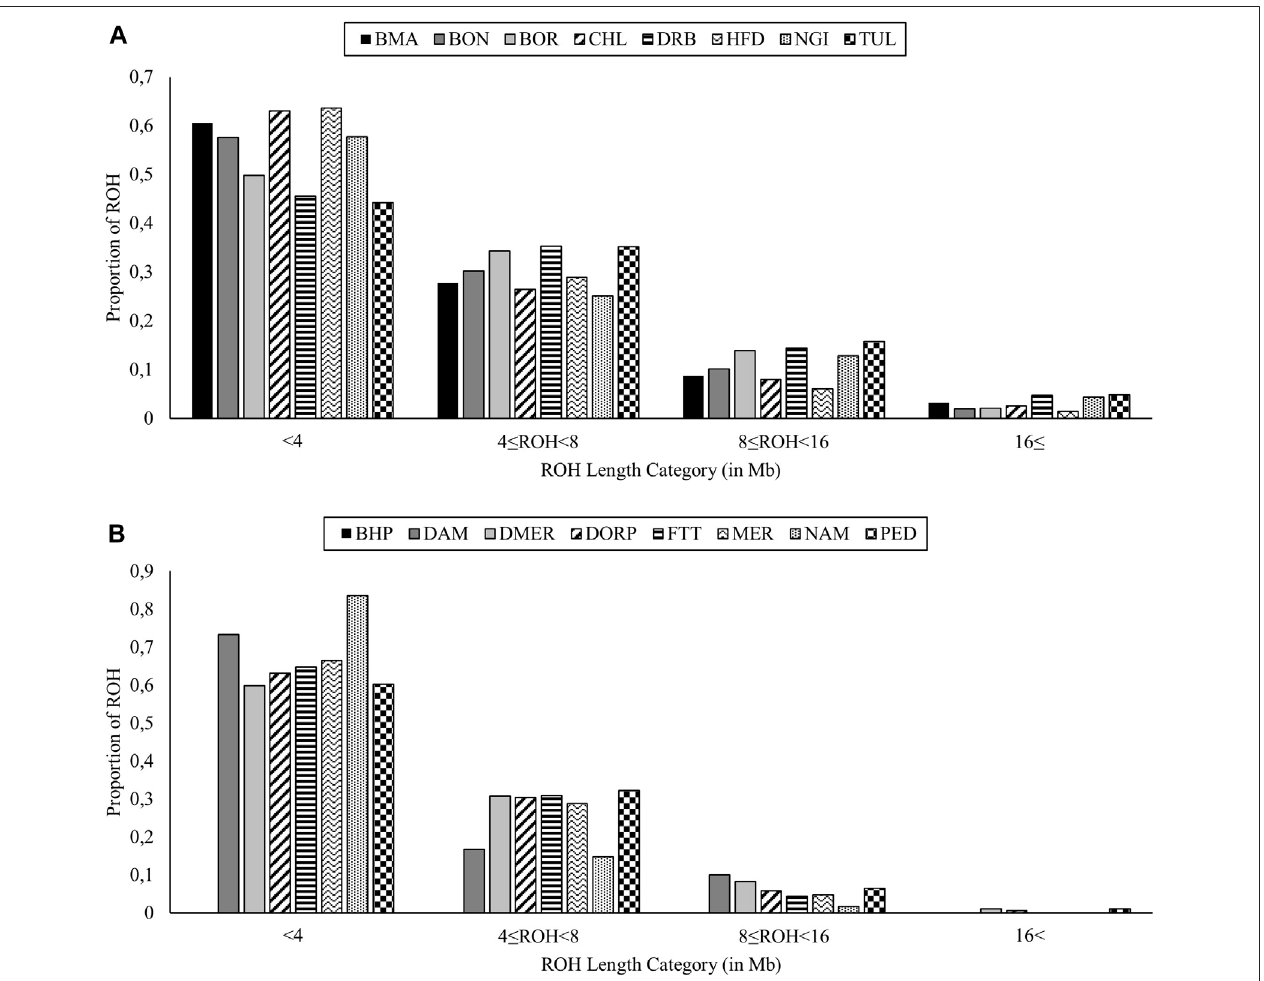
FIGURE 2 | Distribution of runs of homozygosity (ROH) segments within different length categories for cattle (A) , and sheep (B) populations.